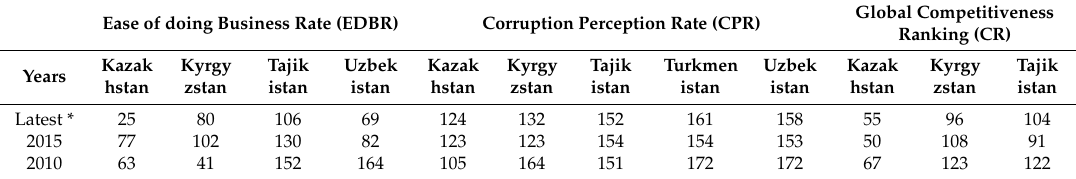
Table 11. Selected Rankings for the Quality of Institutional Environment in Central Asian Economies (Source: author, based on Ease of Doing Business, http: // www.doingbusiness.org; Corruption Perception